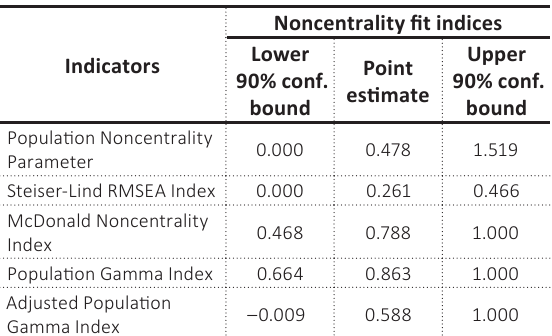
Table 6. Model noncentrality indices of the relationship between NPLs of banking institutions, profitability and financial stability of